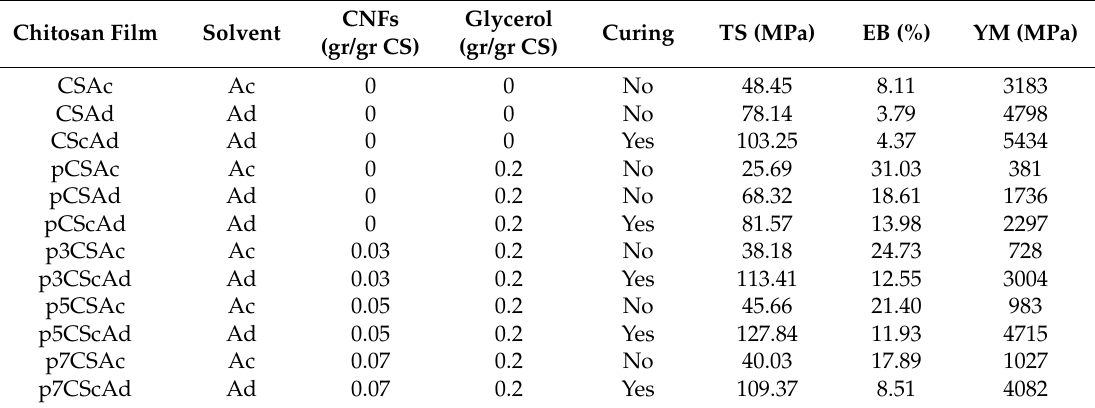
Table 2. Comparison of mechanical properties of chitosan